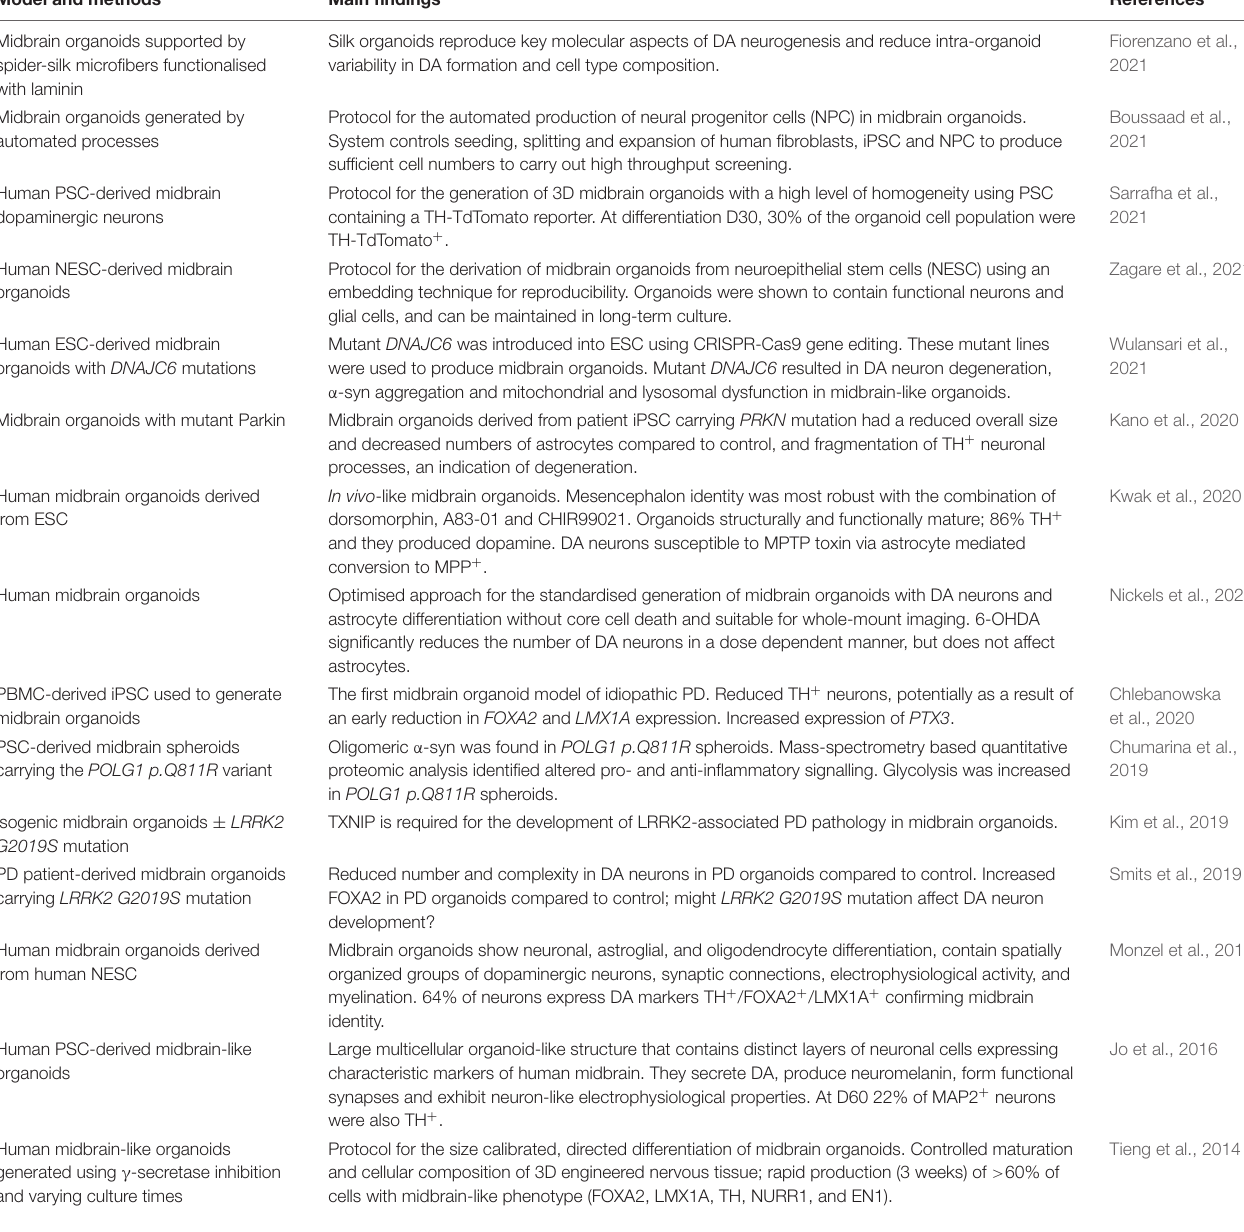
TABLE 2 | Summary table of the protocols for the generation of midbrain organoid models and the main findings from these model